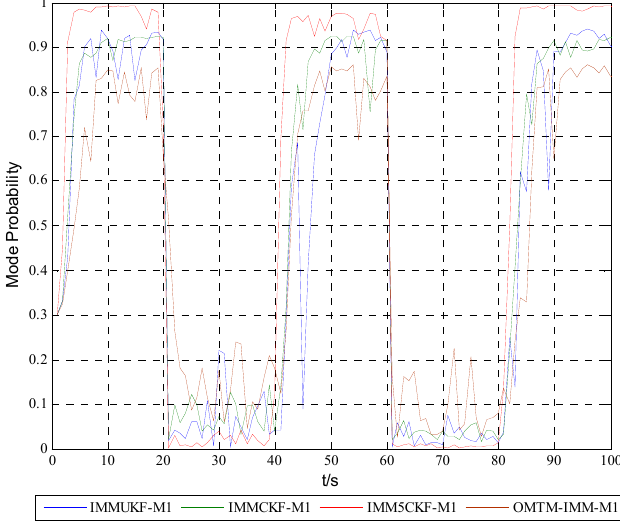
Figure 5. Model probabilities of model 1.